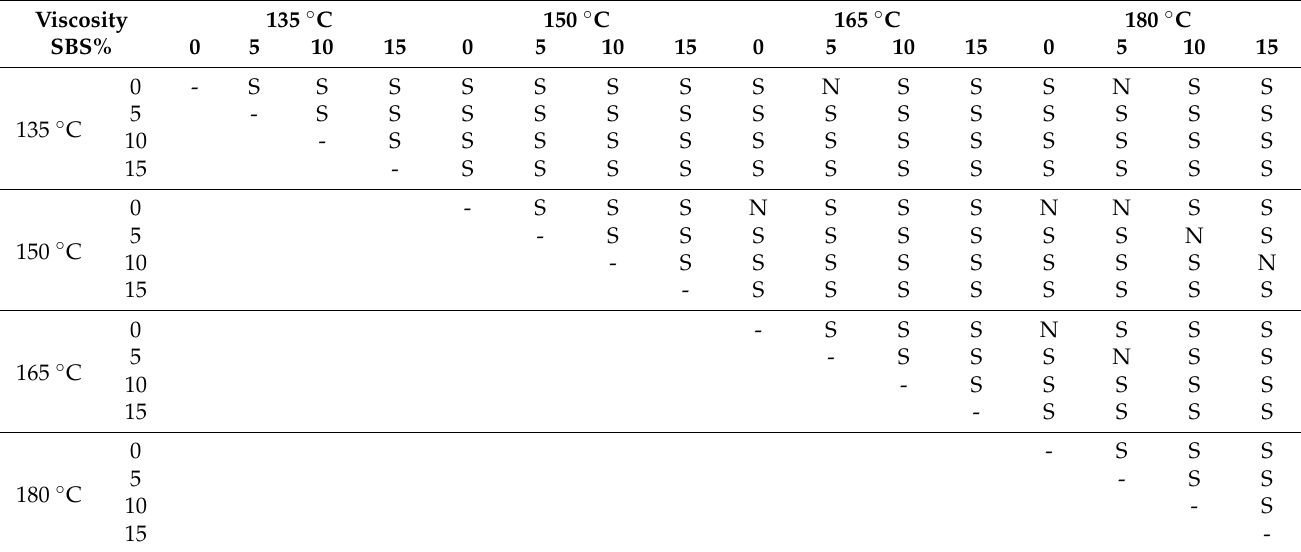
Table 7. Statistical analysis results of viscosity for PG 64-22 with 12% processed oil as a function of SBS content ( α =